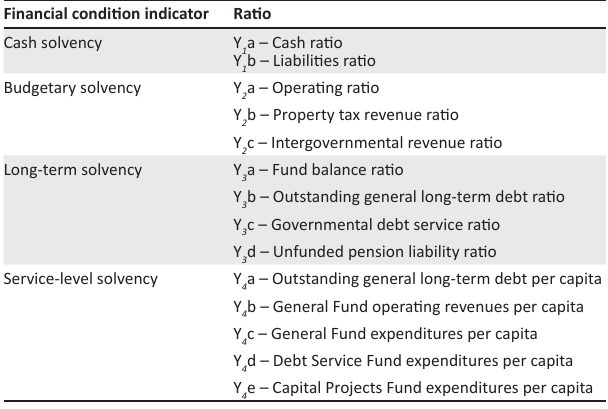
TABLE 1: Financial condition